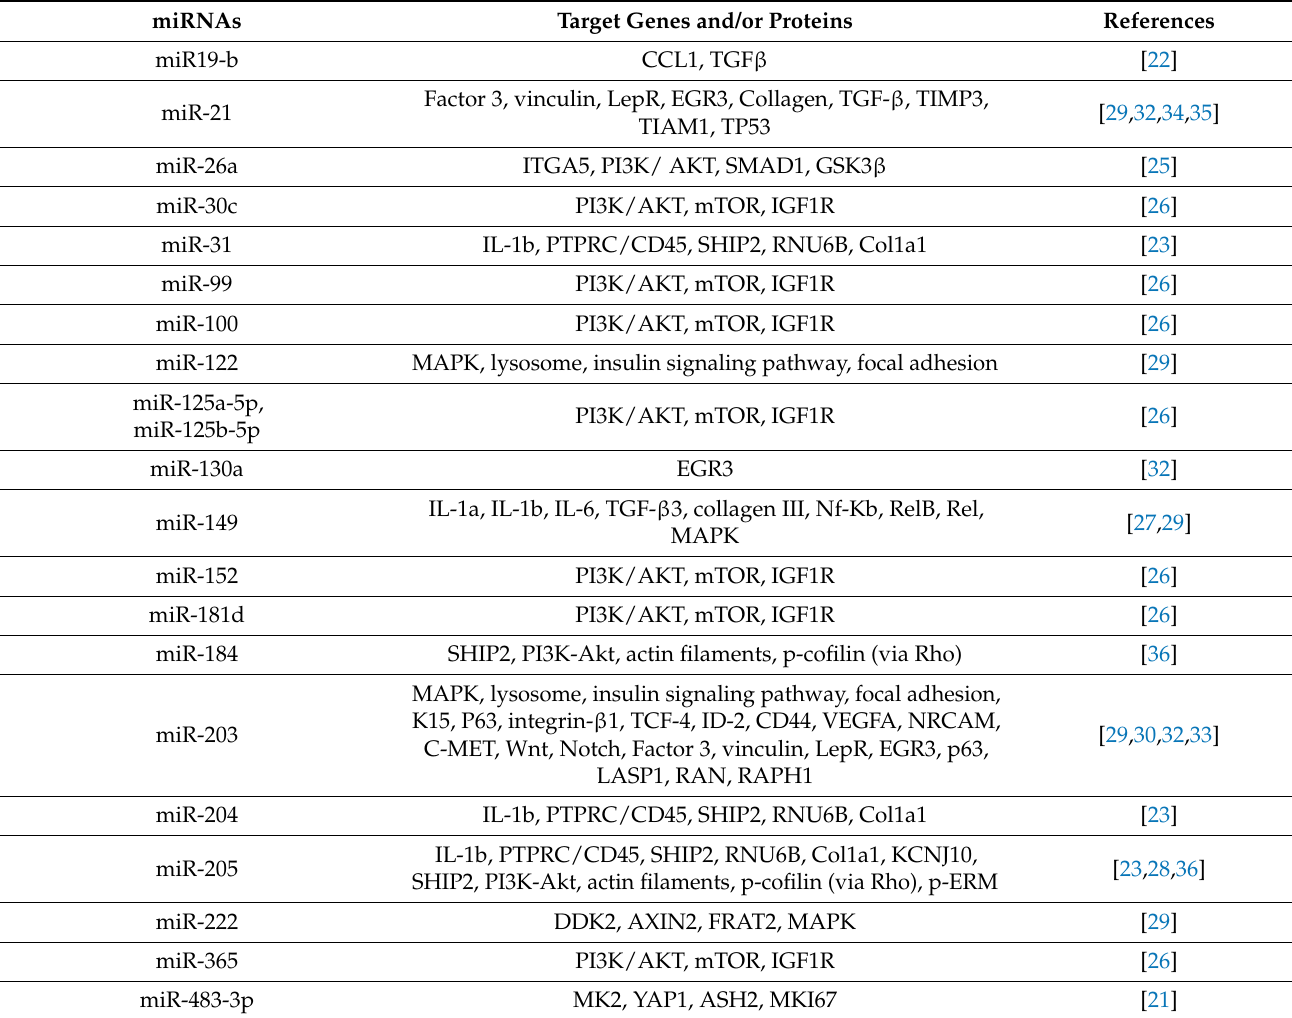
Table 3. The list of miRNAs pinpointed by the included papers and the respective target genes, when available. miRNAs Target Genes and/or